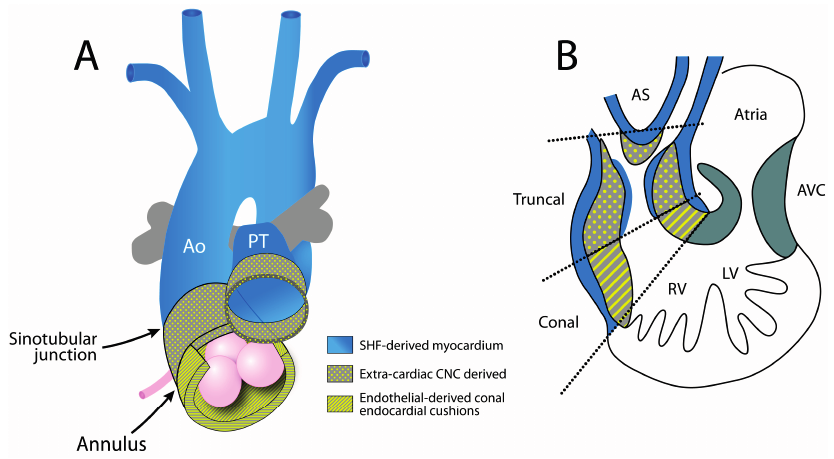
Figure 3. Genesis and cellular contributions to the outflow tract. Schematic shows the locations of outflow tract (OFT) colonization by the extra-cardiac cardiac neural crest (blue), vascular smooth muscle derived from the second heart field (dotted yellow) and the location of myocardium from derived from the second heart field (striped yellow). The aortic annulus or hinge region is formed where myocardial cells meet the vascular smooth muscle cells of the media of the aorta and pulmonary trunk and endothelial derived mesenchyme is the source of the fibroblastic annular tissue. The media of the aorta and pulmonary trunk is derived from secondary heart field proximally (dotted yellow) and the cardiac neural crest distally (blue). The interface between these populations is at the sinotubular